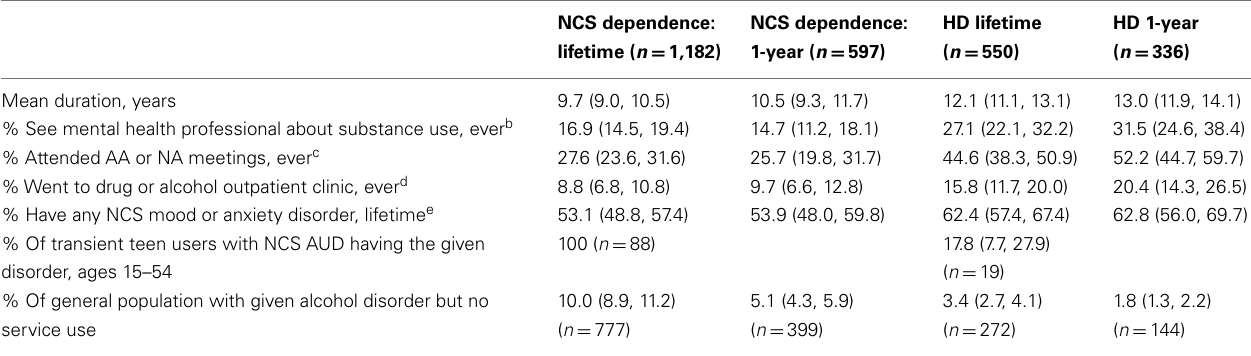
Table 7 | Means and percentages (95% confidence intervals) for validators of NCS lifetime and 1-year a alcohol dependence disorders versus HD AUD, ages 18–54, N = 7,599